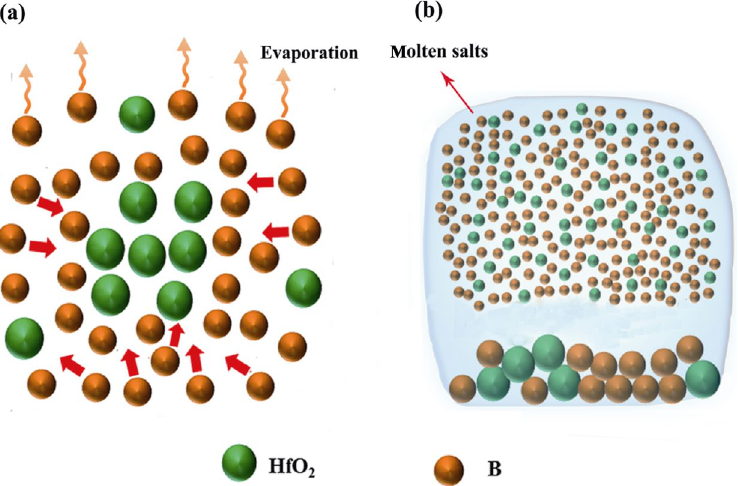
Fig. 4 Schematic diagrams of formation mechanisms associated to the as-synthesized HfB 2 powders: (a) without molten salts and (b) with molten